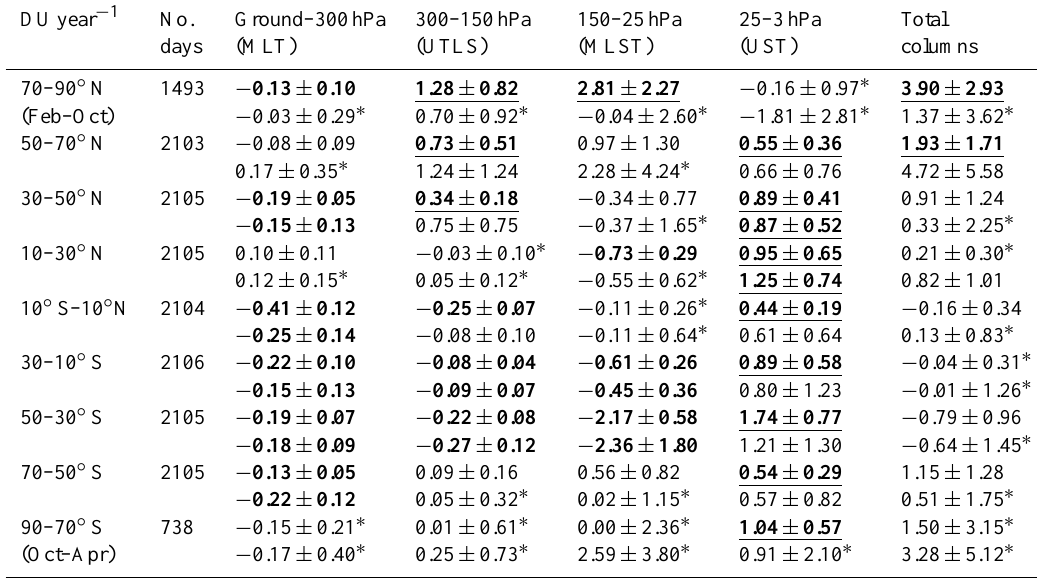
Table 2. Ozone trends and associated uncertainties (95% confidence limits; accounting for the autocorrelation in the noise residuals), given in DUyear − 1 , for 20 ◦ latitude bands, based on daily (top values) and monthly (bottom values) medians over 6 years of IASI observations. Bold (underlined) values refer to significant (positive) trends. Values marked with a star (*) refer to trends which are rejected by the iterative backward elimination procedure a